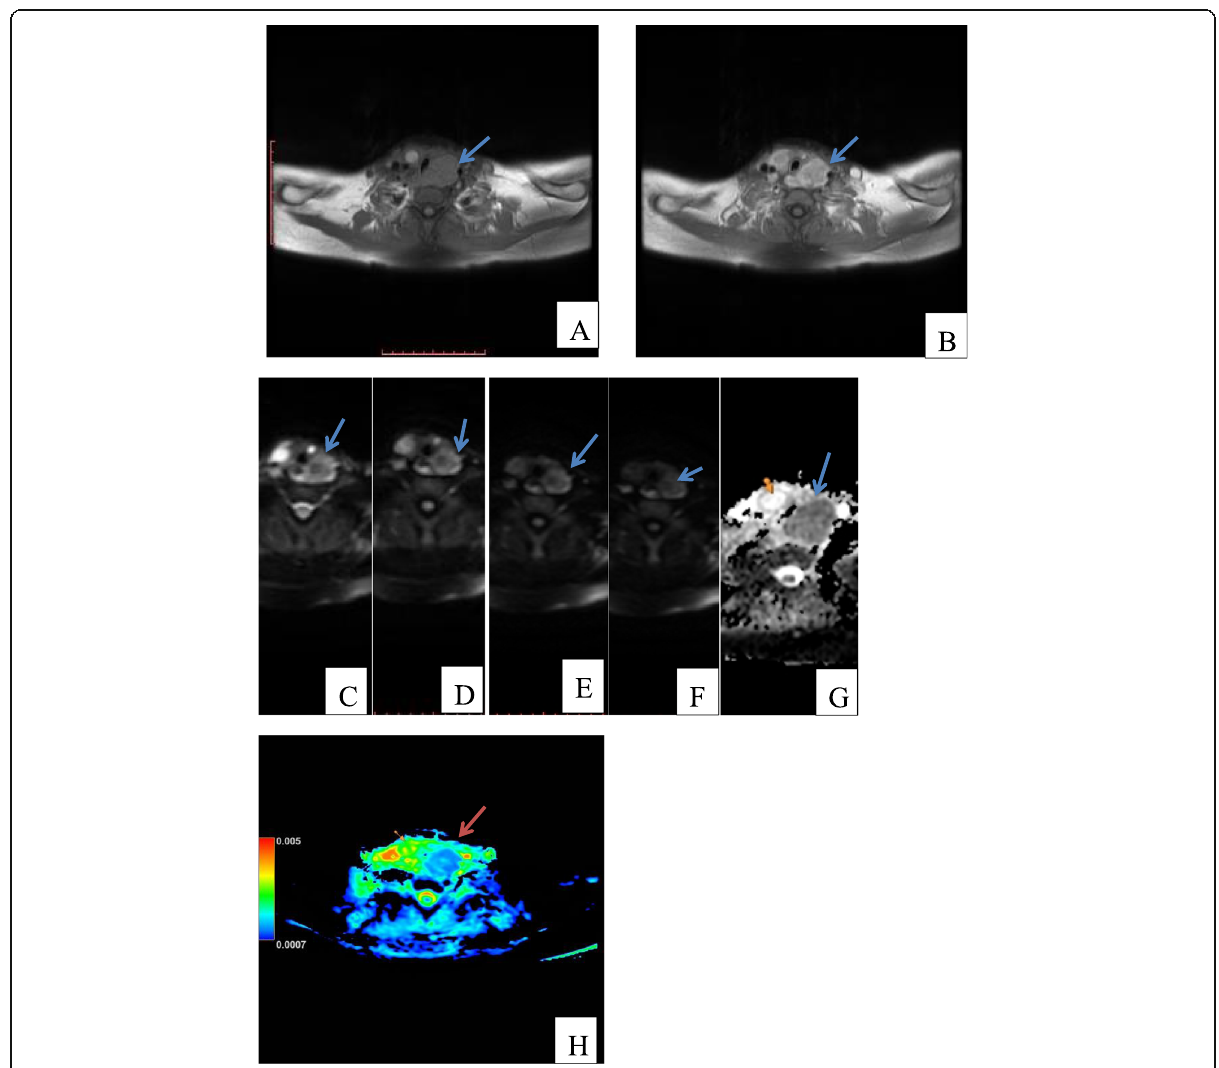
Fig. 5 Twenty-two-year-old female patient with nodular goiter. a Axial T1. b Axial T1 with contrast. d – f Axial diffusion-weighted imaging with b values: 50, 400, 800, and 1000 respectively. g ADC map (gray). h ADC map (colored) showed multiple thyroid nodules detected in both thyroid lobes, the largest at right thyroid. The nodules showed high signal intensity in T1 and peripheral ring enhancement after IV contrast. It elicited high signal in DWI, in low b values, with rapid signal decayed in high b values, showing the same signal intensity of normal thyroid tissue at b value 1000, with corresponding high signal intensity at ADC map (free diffusion), ADC value = 2.21 × 10 − 3 s/mm 2